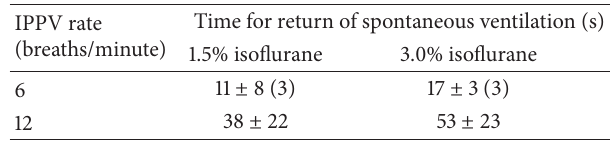
Numbers in parentheses indicates the number of birds that developed